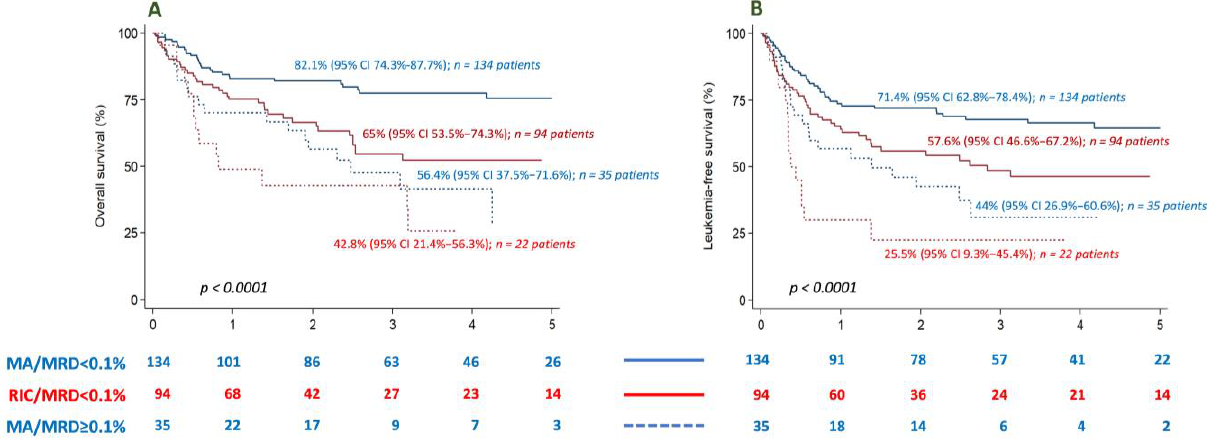
Figure 4. Impact of MRD in OS and LFS, according to conditioning regimen. Patients with MRD < 0.1 before transplantation had a better OS ( A ) and LFS ( B ) at 2 years, with both types of conditioning.